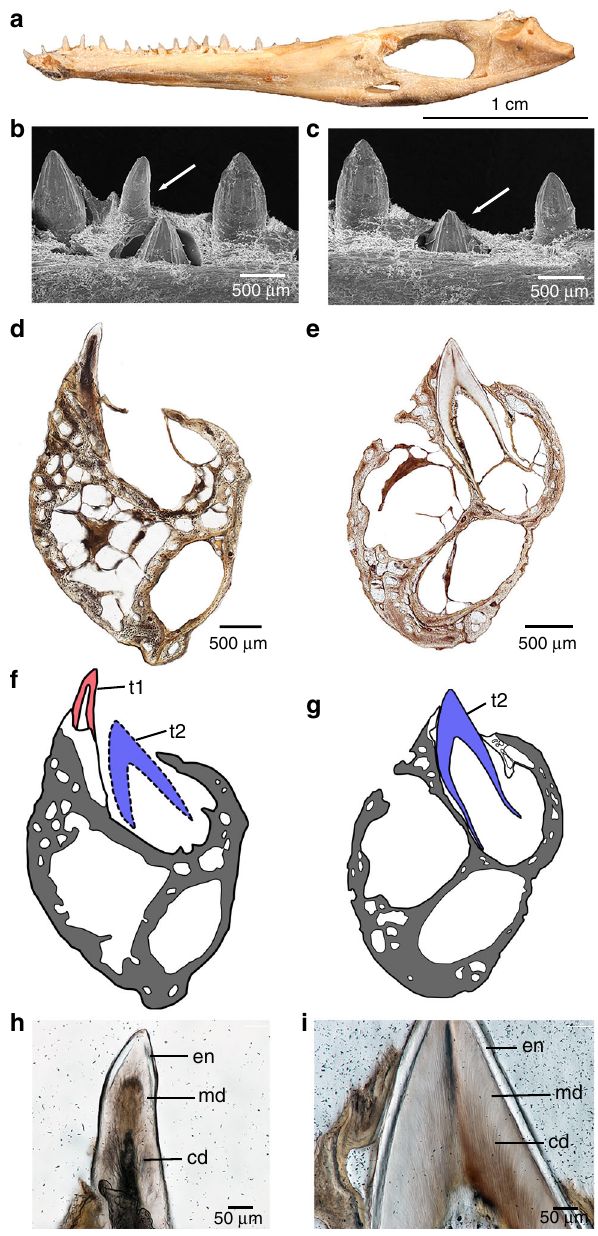
Fig. 3 Tooth development in a 1 day-old Alligator mississippiensis hatchling (ROM R7964). a Right dentary of ROM R7964. b Scanning electronic microscopic image of the small embryonic tooth sectioned in ( d ) (white arrow) showing larger replacement tooth visible in lingual view. c Scanning electronic microscopic image of replacement tooth sectioned in ( e ) (white arrow) in lingual view. d Thin section of the left dentary of